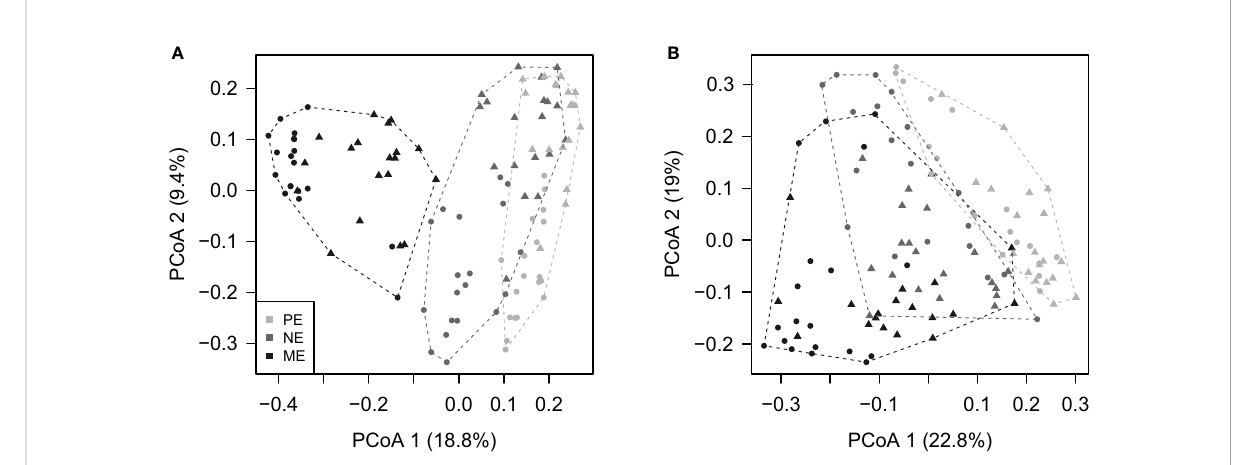
FIGURE 4 Principal coordinate analysis (PCoA) plots based on (A) unweighted and (B) weighted UniFrac distances showing the beta diversity patterns of the PE, NE, and ME categories. The dashed lines surrounding the symbols (i.e., the fi lled circles indicating surface samples, and fi lled triangles indicating bottom samples) delineate the convex hull for each category and are drawn in the same